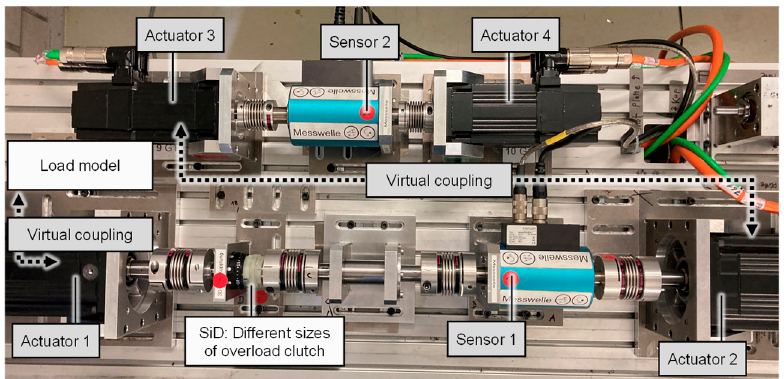
Figure 11. sCiL test bench for performing the verification of the scaled examination. The sCiL test bench contains the mechanical components of the drive train of a cordless screwdriver. The virtual coupling is integrated between actuator 2 and actuator 3 as well as between actuator 1 and the virtual load model in the drive